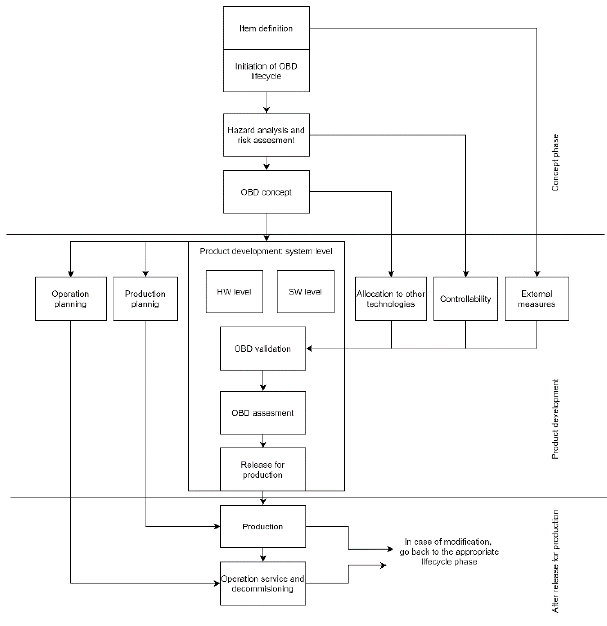
Fig. 1. OBD OBM lifecycle based on FuSa lifecycle